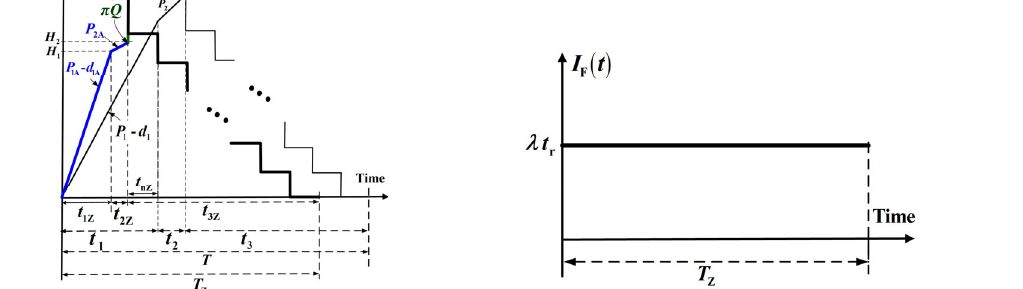
Fig. 6. Situation two’s safety stock